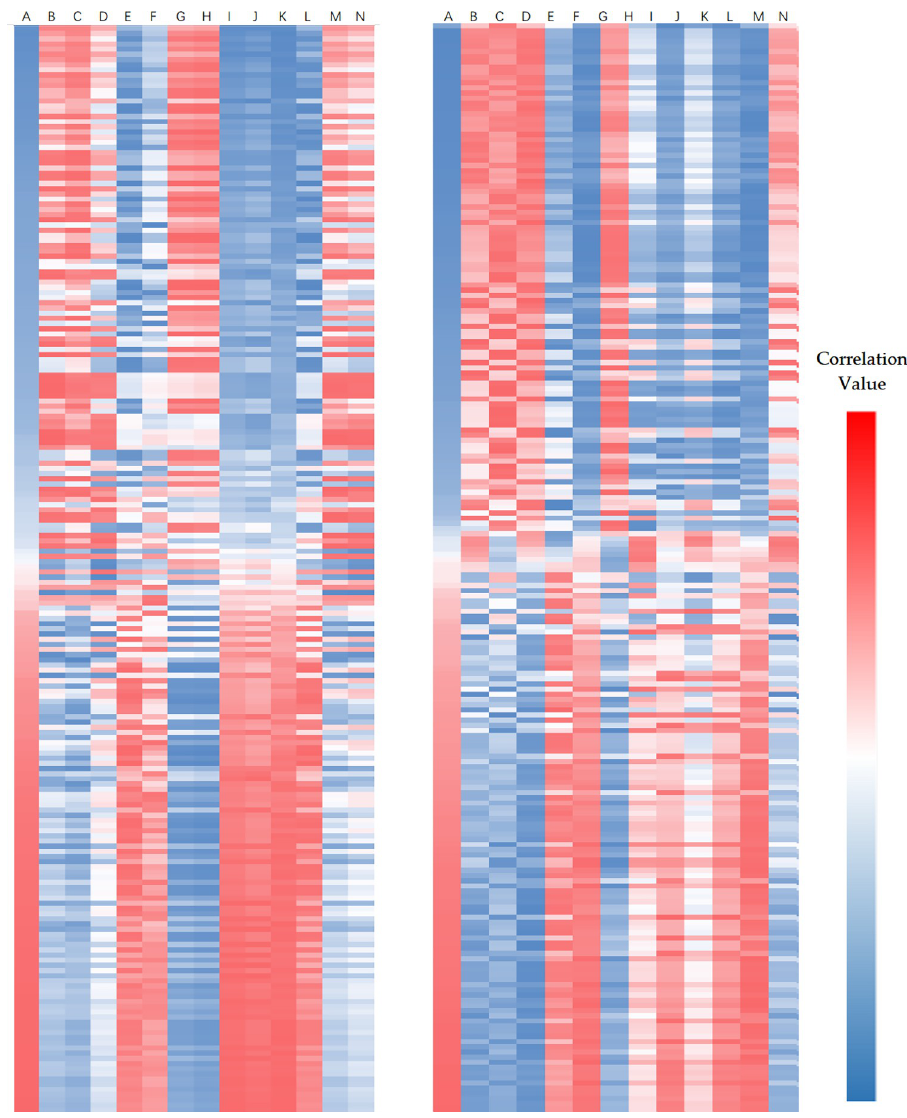
Fig 3. Correlation heatmap of the Forsythia related metabolites in leaves and fruits in each harvesting period ranking by correlation values of forsythiaside. The two heatmaps represent the correlations between the metabolites and the Forsythia related metabolites in fruits and leaves, respectively. Heatmap of fruits was listed on the left, that of leaves was listed on the right. Each Forsythia related metabolites is represented by a single column, as follows: A: forsythiaside C, B: forsythoside B, C: rengyoside B, D: rengyoside A. E: forsythiaside B, F: forsythiaside J, G: forsythiaside A, H: isoforsythoside A, I: forsythialan B, J: forsythialan A, K: phillygenin, L: phillyrin, M: 11-methyl- forsythide, and N forsythide. Red and blue color denote positive and negative